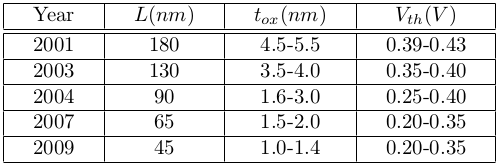
Table from the paper: Analytical Inverter Delay Modeling Using Matlab's Curve Fitting Toolbox
Table text:
Year
L(nm)
t ox (nm)
V th (V)
2001
180
4.5-5.5
0.39-0.43
2003
130
3.5-4.0
0.35-0.40
2004
90
1.6-3.0
0.25-0.40
2007
65
1.5-2.0
0.20-0.35
2009
45
1.0-1.4
0.20-0.35